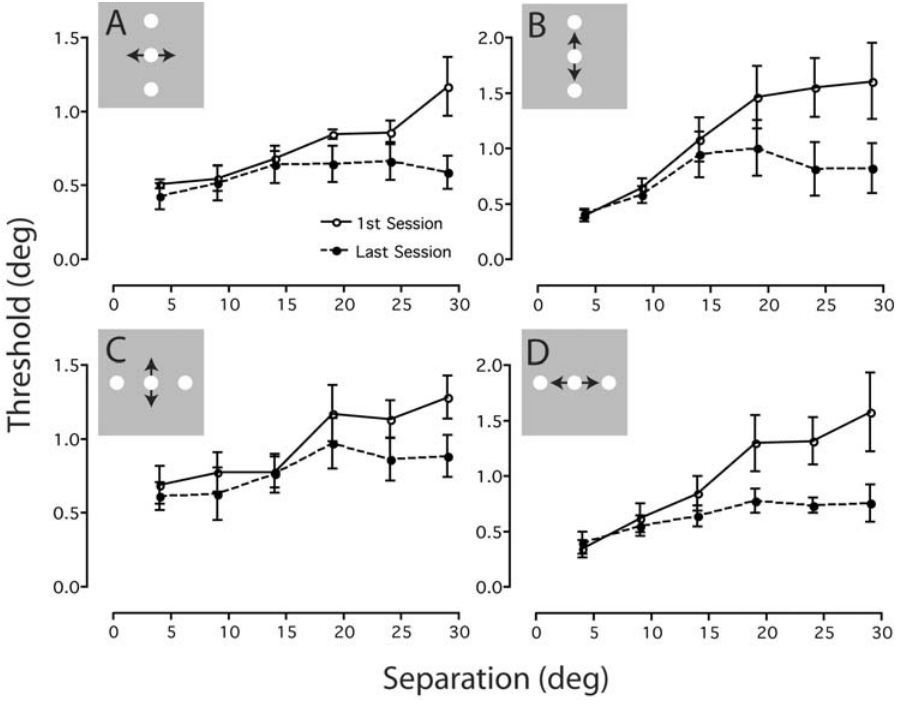
Figure 3. Positional learning for each task and stimulus configuration. Mean positional thresholds obtained on the first and last days for groups trained on a) vertical alignment, b) vertical bisection, c) horizontal alignment and d) horizontal bisection. Learned improvements in task performance are consistently seen for large, but not small, stimulus separations. Error bars are SEM.